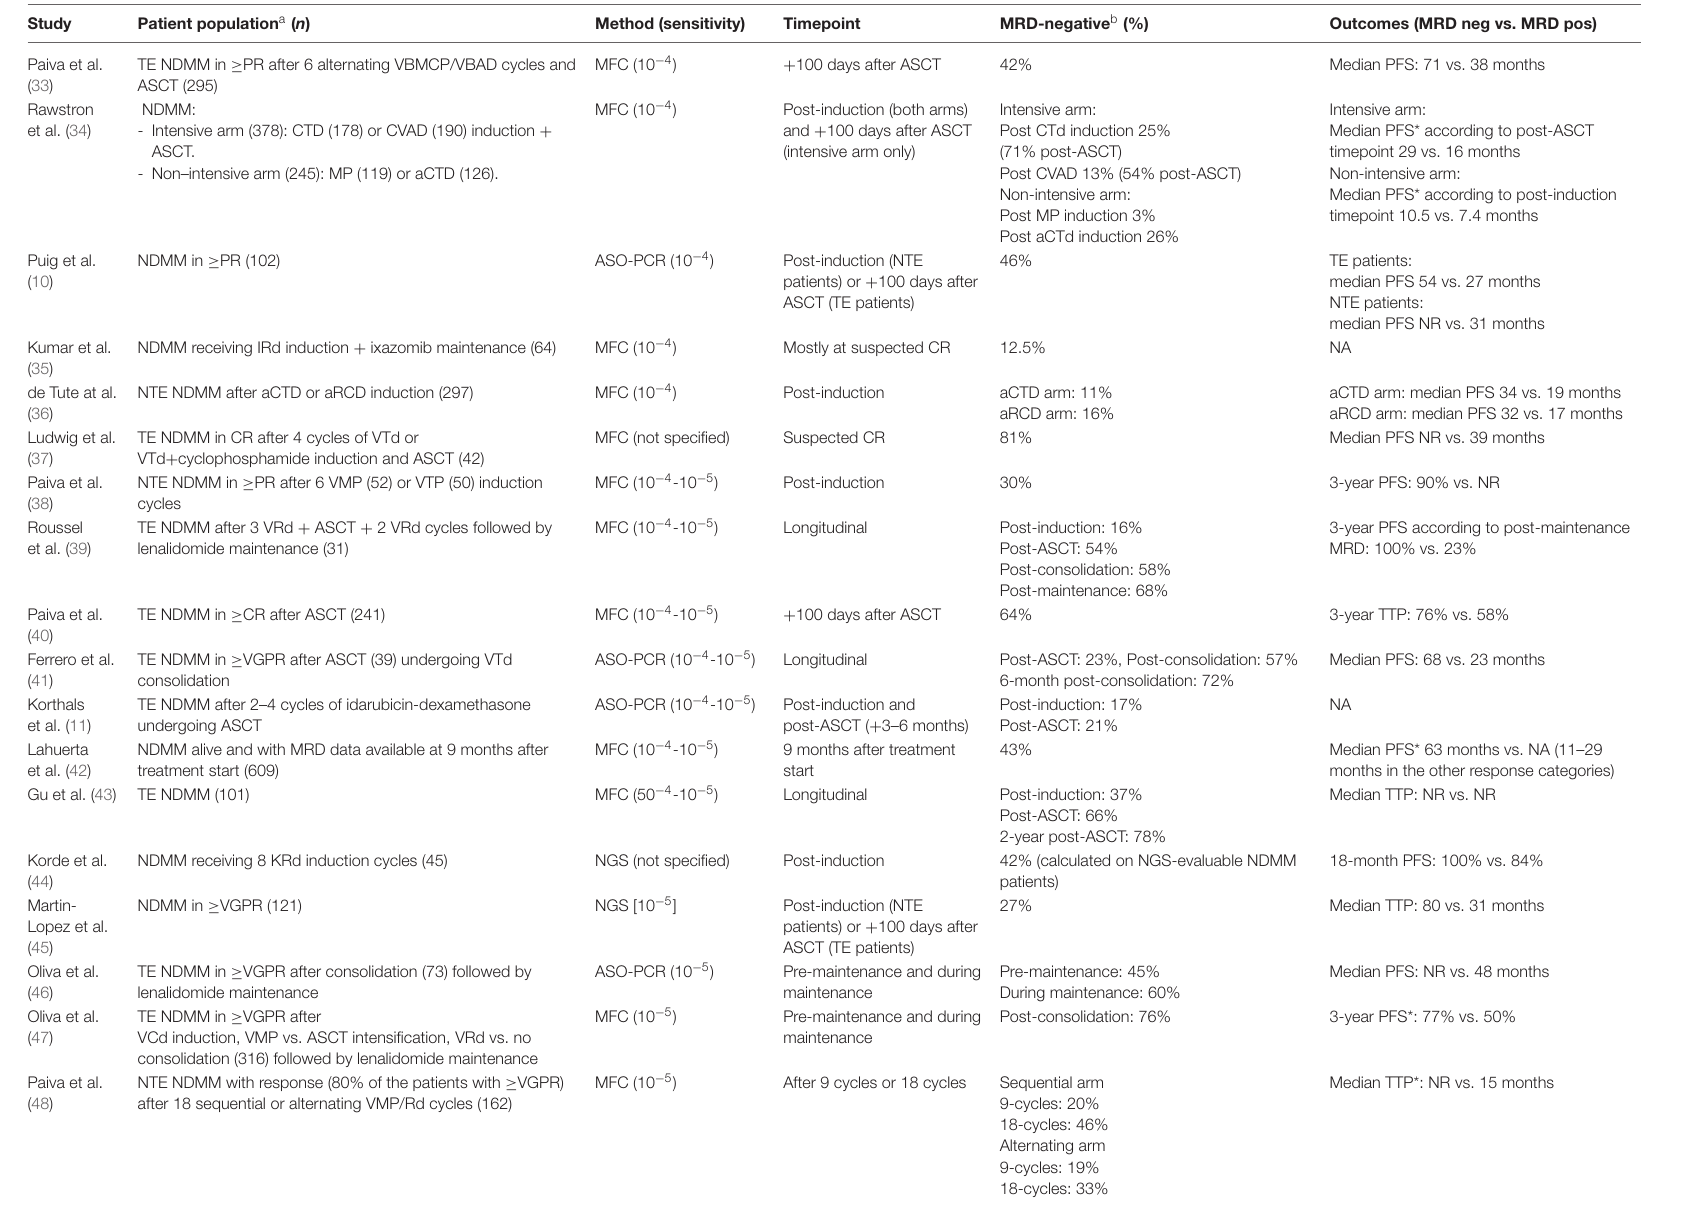
TABLE 2 | Selected trials on NDMM patients reporting MRD